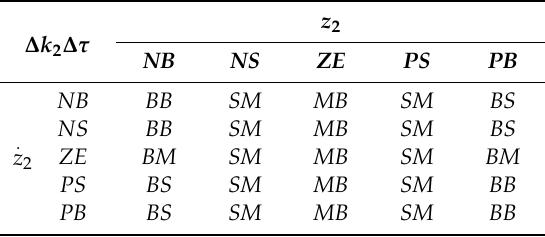
Table 1. Fuzzy rules of the